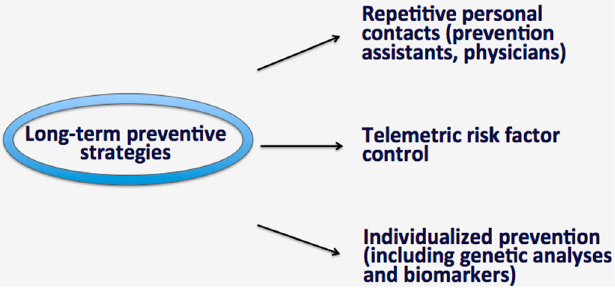
Figure 3. Strategies to increase attractiveness of long-term prevention programmes.